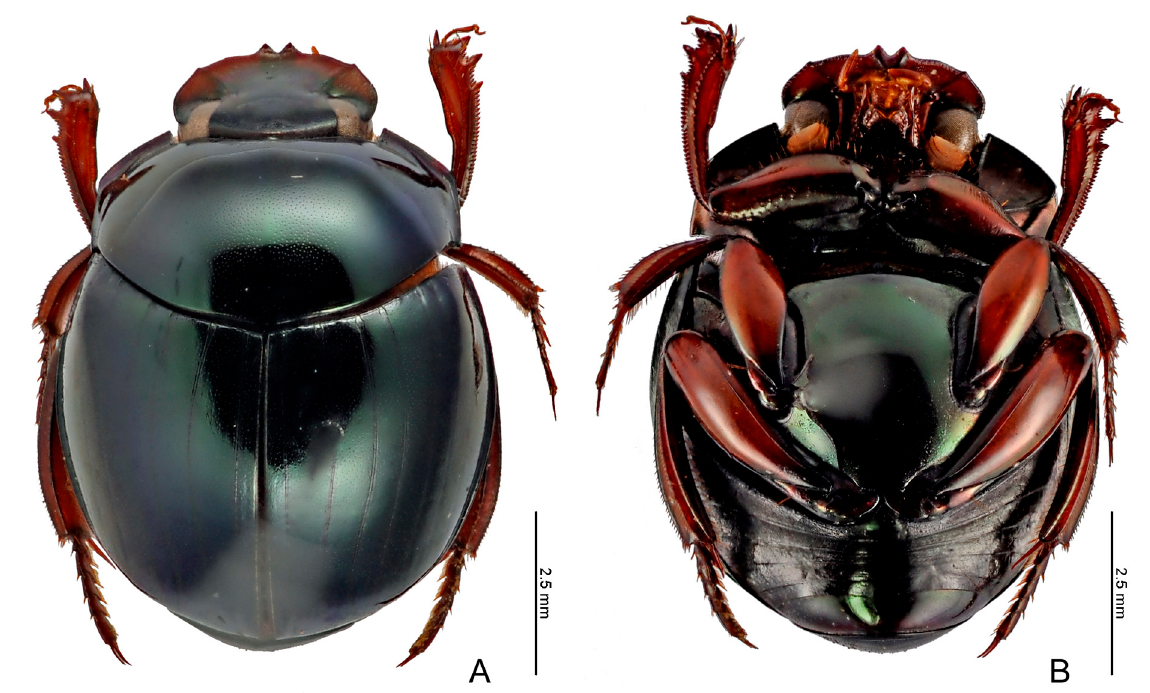
Fig. 39. Sylvicanthon securus (Schmidt, 1920) comb. nov. A . Dorsal view. B . Ventral